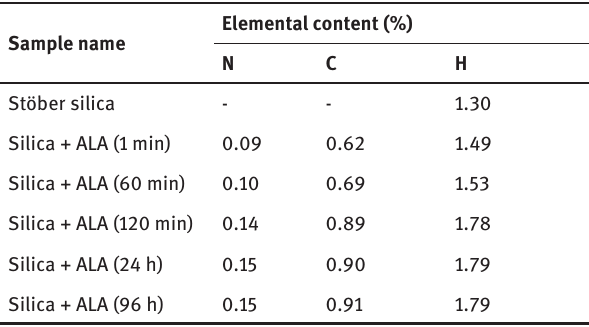
Table 1: Results of elemental analysis of silica after Amano Lipase A immobilization.